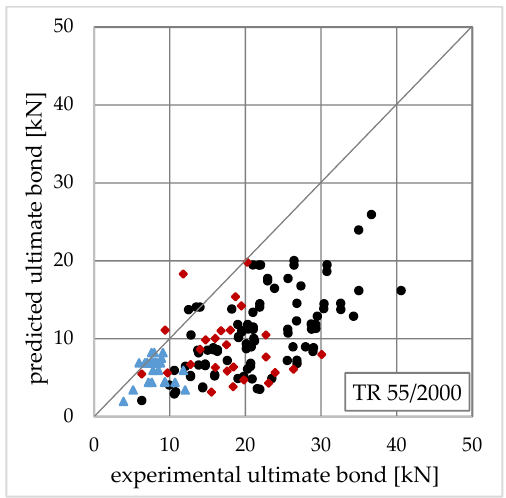
Figure 19. Test vs. predicted bond force using the Camli and Binici model [31].